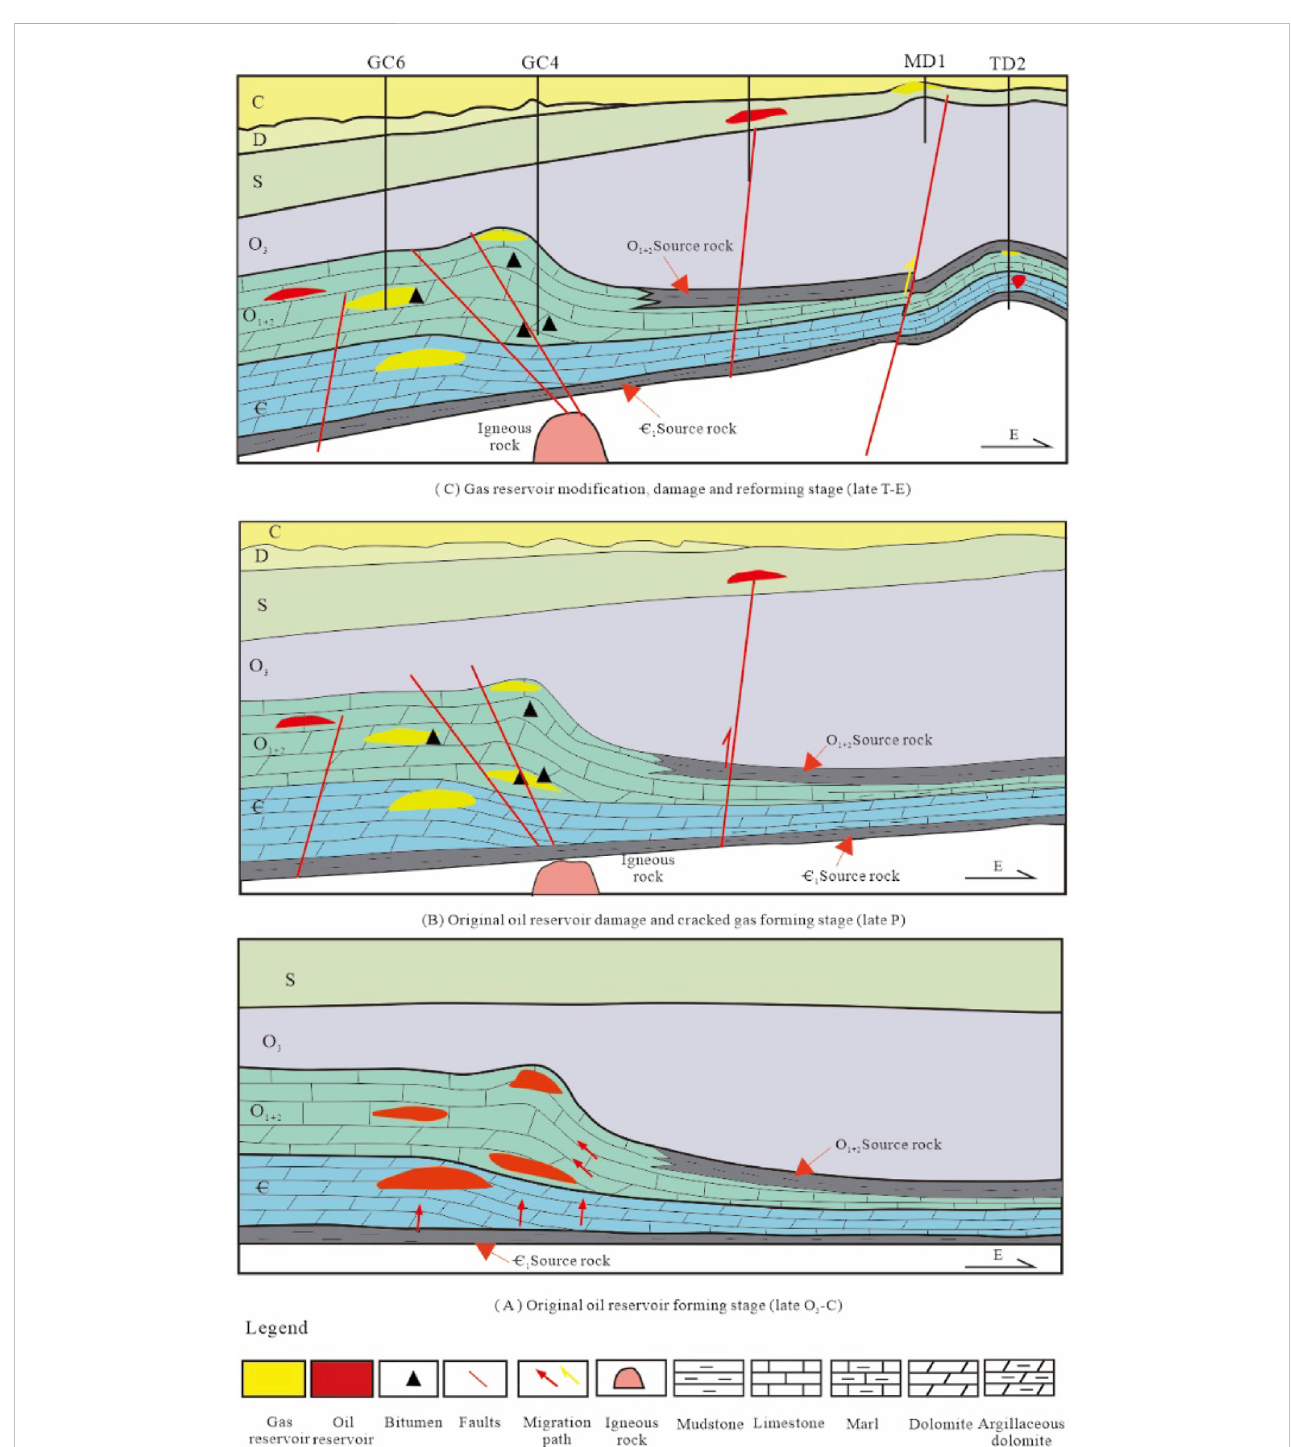
FIGURE 8 Hydrocarbon accumulation and evolution model in Gucheng area, Tarim Basin. (A) Formation of the primary oil and gas reservoir. The hydrocarbon generationofthethreesourcerocksintheCambrian – OrdovicianoftheTarimBasinlastsuntilthelateHercynianstage,duringwhichtheprimaryoilreservoirs areformed,mostlyincarbonaterocktrapswithsomeintheSilurianclasticrock. (B) Destructionandcrackingoftheprimaryoilreservoir.Duetothemagmatic hydrothermalactivitiesofmulti-stagetectonicthermaleventsduringtheCaledonianandHercynianstages,theprimaryoilreservoirsaresubjectedtooil cracking and the cracking gas reservoirs and residual paleo-oil reservoirs (or bitumen) are formed. (C) Adjustment, destruction, and reforming of gas reservoirs. The study area is tectonically stable after the Triassic. The trap integrity is maintained, and the preservation condition is good. The Cambrian – Ordovician source rock in the Manjiaer depression enters the hydrocarbon generation depletion stage, and part of crude oil is converted into natural gas via cracking, which forms condensate reservoirs. The dispersed residual organic matter in the source starts to generate gas at a large scale and forms the Himalayan gas reservoir, mostly occurring in traps related to the Himalayan